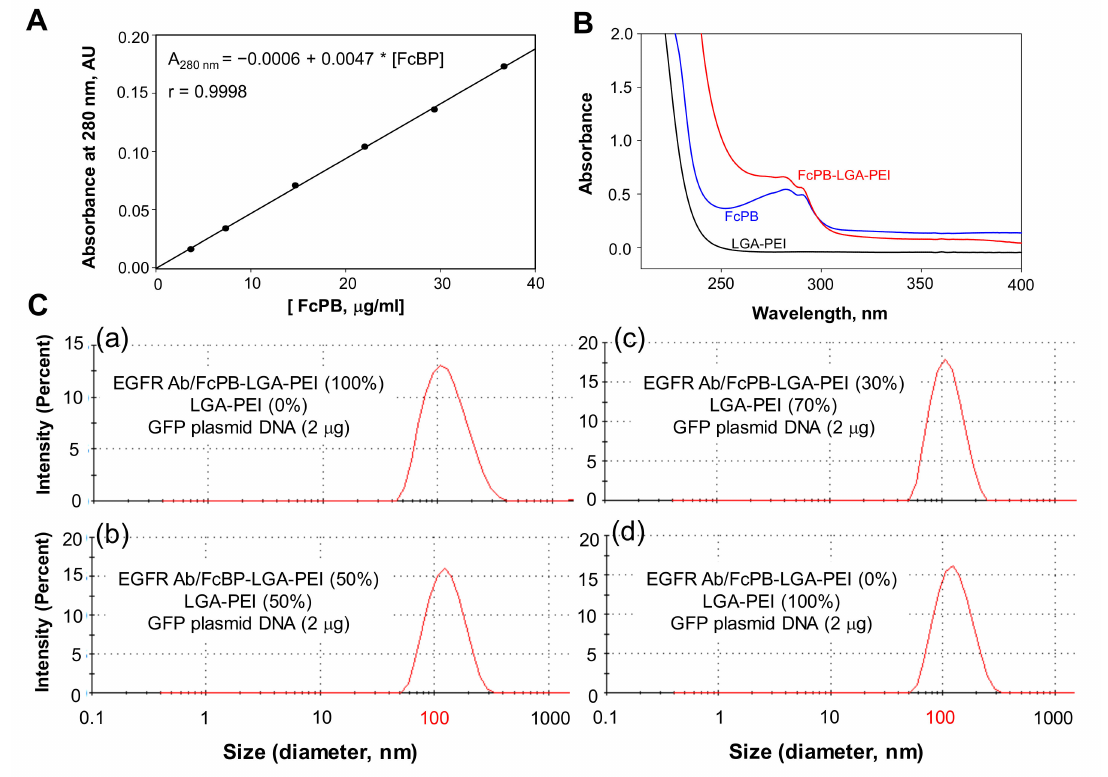
Figure 2. Synthesis of the FcBP-LGA-PEI polymer and nanoparticle (NP) formation with whole antibody (Ab) and nucleic acids. Conjugation of FcBP with the LGA-PEI polymer for binding full Ab for the targeting delivery. PEG (Mal-PEG-NHS) was covalently linked to LGA-PEI (Supplementary Figure S1). FcBP was covalently linked to the Mal-PEG-PEI-LGA though a click reaction. ( A ) Standard curve of spectroscopic analysis for the FcBP standard at 280 nm with different concentrations. Where f = y0 + a ∗ x, y0 = − 0.0006, a = 0.0047, R = 0.9998. The solvent was phosphate buffer (pH 7.2). ( B ) Confirmation of conjugation of FcBP to the LGA-PEI polymer, and determination of FcBP content in the FcBP-LGA-PEI polymer. The concentration of FcBP was 65 µ g/mL, while LGA-PEI was 10 mg/mL. ( C ) Effect of different anti-EGFR Ab/FcBP-LGA-PEI and LGA-PEI ratios on the size of NP formation with plasmid DNA. Full Ab (anti-EGFR Ab) is docked into FcBP-LGA-PEI to form the anti-EGFR Ab/FcBP-LGA-PEI polymer. NPs are formed from a total of 5 µ g of two polymers, anti-EGFR Ab/FcBP-LGA-PEI and LGA-PEI at different ratios with 2 µ g plasmid DNA (double-stranded, circular DNA, 4.7 kbp) in 100 µ L DI water ( a – d ). NP sizes are measured with dynamic light scattering (Zetasizer Nano ZS90). Average sizes are listed in Supplementary Table